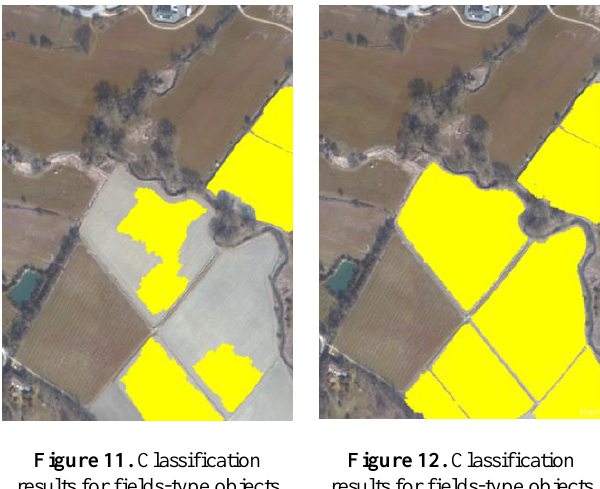
Figure 11. Classification results for fields-type objects